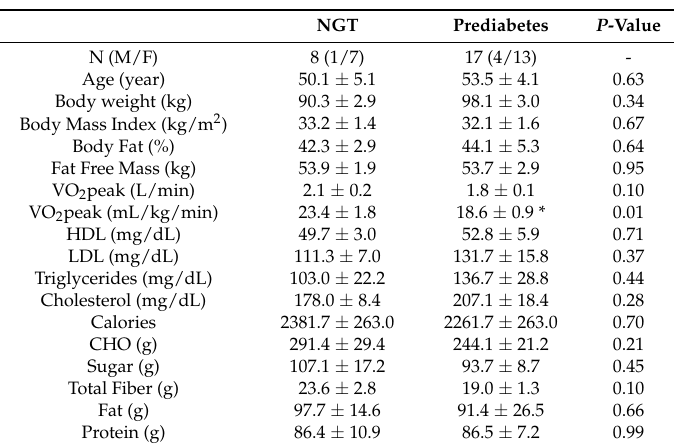
Table 1. Baseline